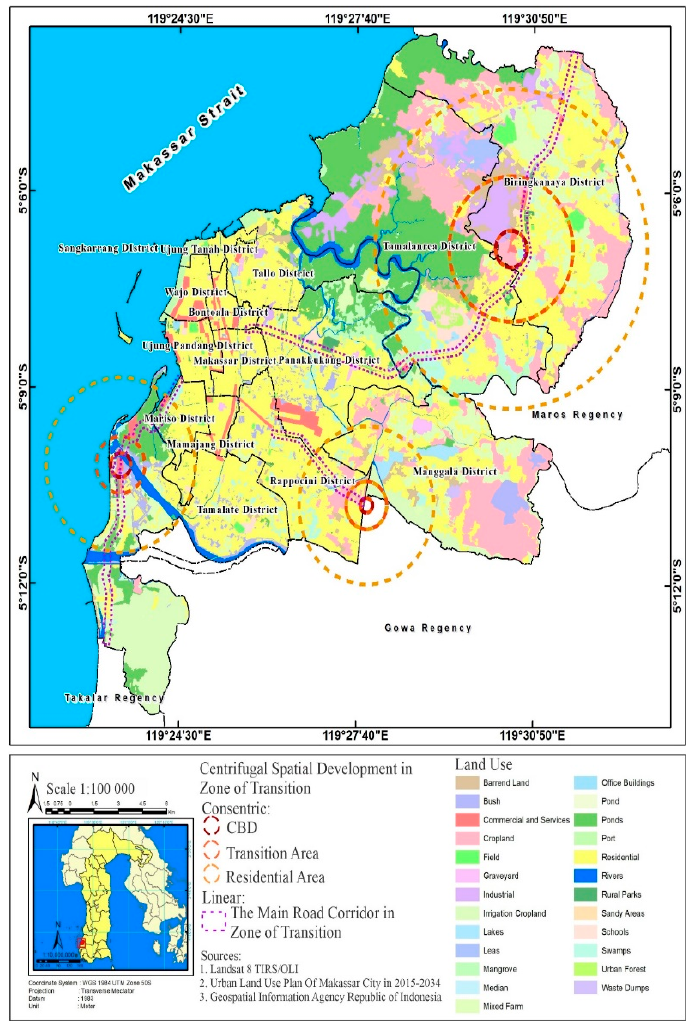
Figure 4. The development of Makassar City is linear and concentric.